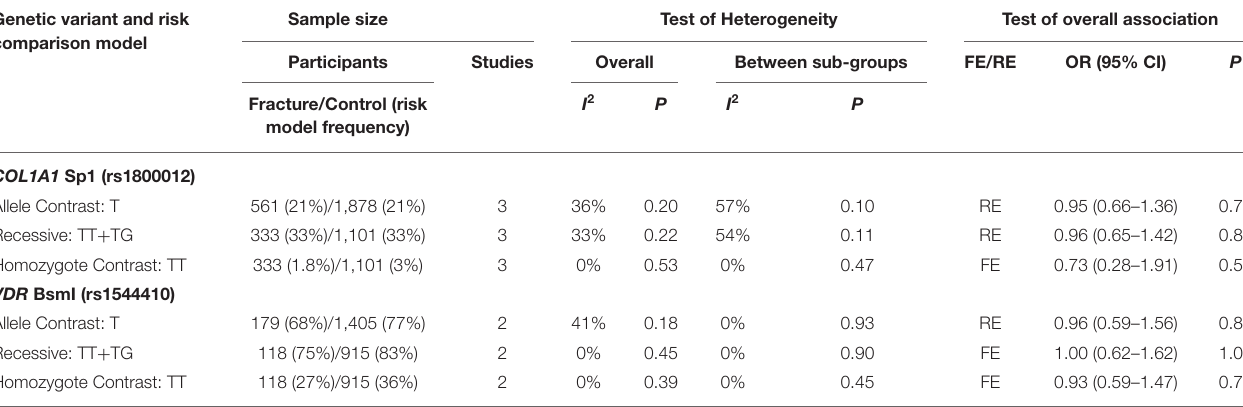
TABLE 4 | Summary effects from the overall analyses of case-control association studies for genetic variants associated with fracture occurrence risk in physically active participants including only good and moderate quality studies with sex sub-groups. Genetic variant and risk Sample size Test of Heterogeneity Test of overall association comparison model Participants Studies Overall Between sub-groups FE/RE OR (95% CI) Fracture/Control (risk model